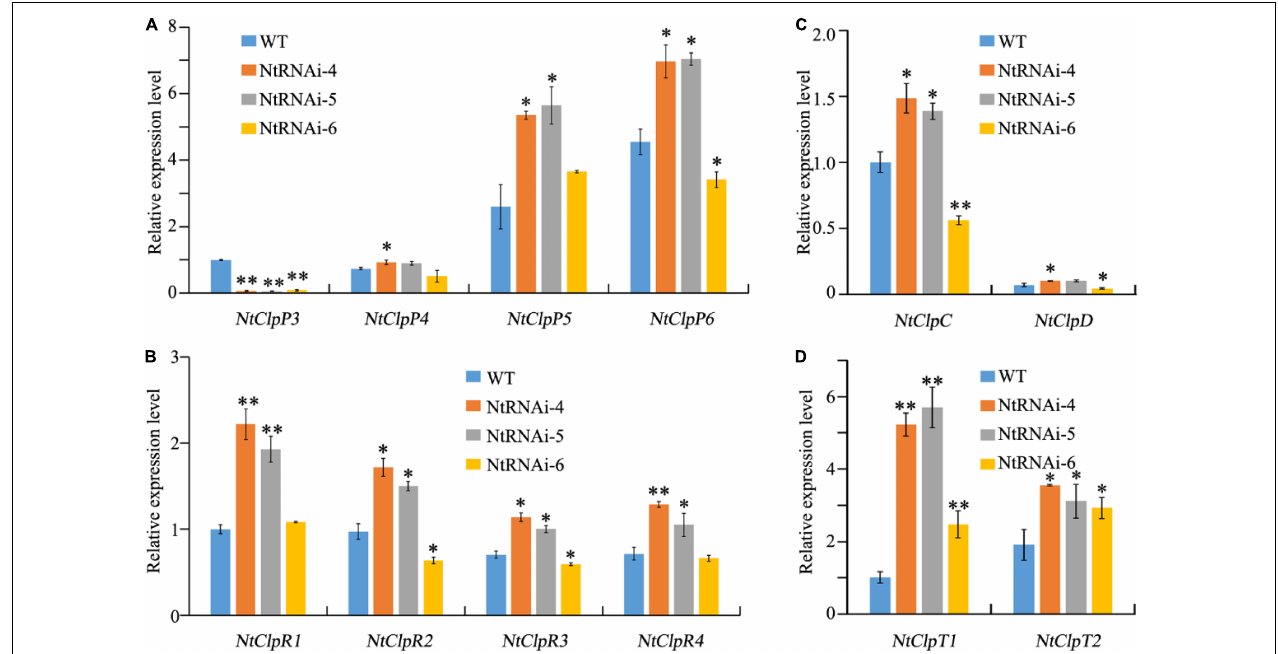
FIGURE 6 | Transcriptional alterations of different Clp complex subunit genes in WT and transgenic tobaccos with suppressed NtClpP3 . (A) Relative transcript levels of ClpP3-6 P-ring genes in transgenics to that of NtClpP3 in WT plants. (B) Relative transcript levels of R-ring ClpR1-4 in transgenics to that of NtClpR1 in WT plants. (C) Relative transcript levels of chaperone ring ClpC and - D in transgenics to that of NtClpC in WT plants. (D) Relative transcript levels of ClpT1-2 in transgenics to that of NtClpT1 in WT plants. One-way ANOVA and t -test analyses were performed to examine the significant differences in transcript levels between transgenic and WT tobaccos. ∗ p < 0.05; ∗∗ p <